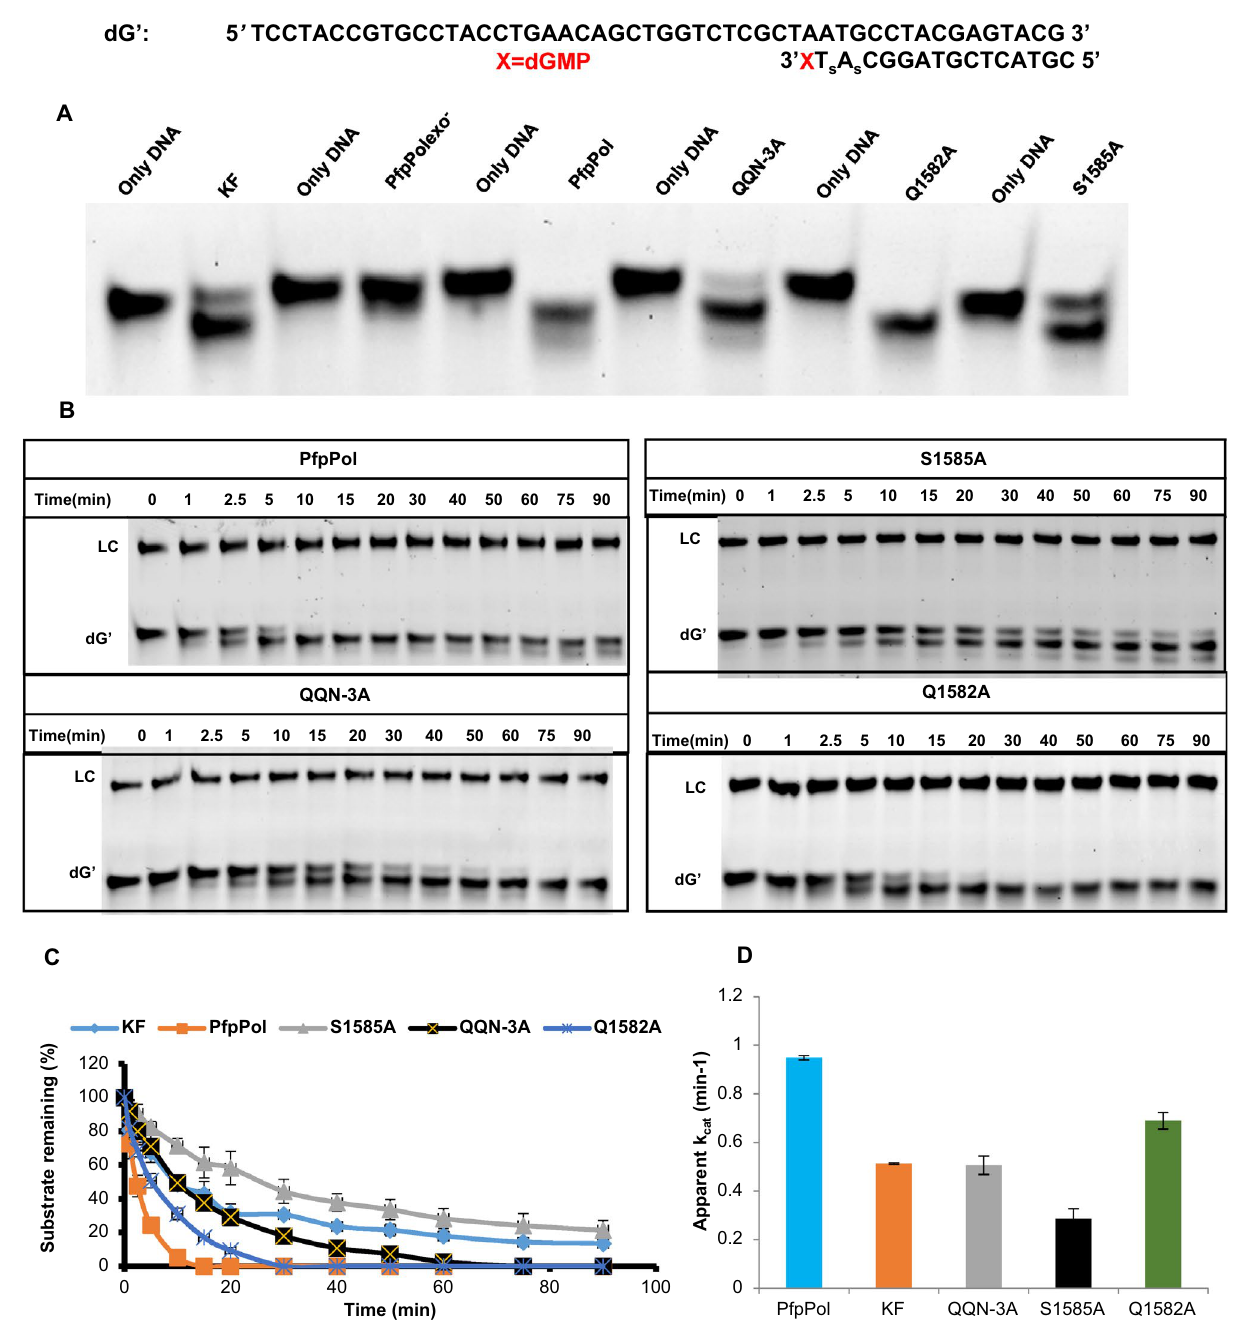
Figure 5. Proofreading activity of PfpPol and the mutant enzymes on dG ′ DNA substrate. ( A ) 10 nM of each of the protein was incubated with 100 nM DNA (dG ′ ) substrate without dNTPs for 1 h at 37 °C. S1585A and QQN-3A show reduction in their exonuclease activity on dGMP terminated primers as compared to PfpPol. PfpPolexo − enzyme was used as a negative control. ( B ) Denaturing PAGE gels showing excision of dGMP from 0 to 90 min. LC and dG’ denote loading control and the DNA substrate with dGMP at the 3 ′ end, respectively. Protein to DNA ratio was maintained at 1:10. ( C ) Percentage of the substrate (dG ′ ) remaining plotted against time of incubation (0 ′ to 90 ′ ) for PfpPol, KF, QQN-3A, Q1582A and S1585A.The error bars denote standard deviation values (n = 3). ( D ) Exonuclease rate of excision of dGMP was determined by incubating each of the protein (10 nM) with DNA (100 nM) for 0 min and 10 min. In comparison to PfpPol, QQN-3A and S1585A showed two and three-fold reduction in excision activity,